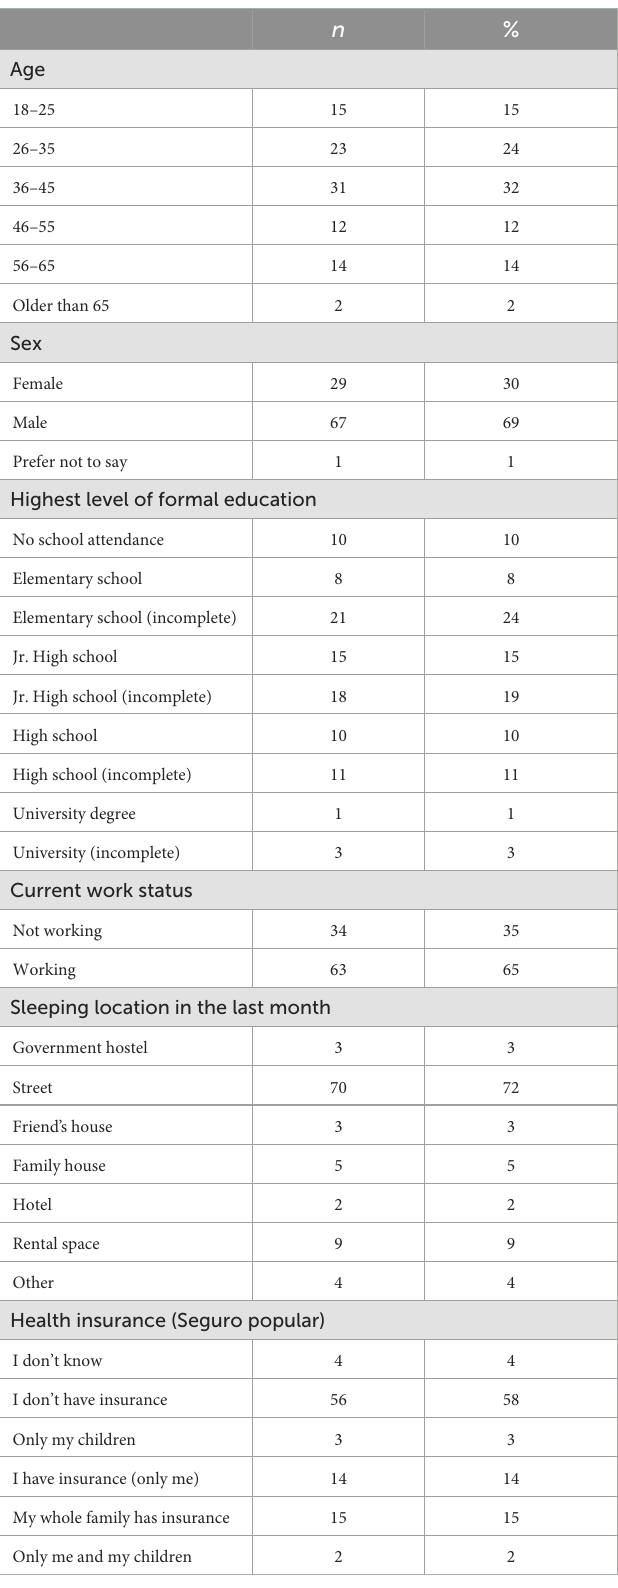
TABLE 1 Participant